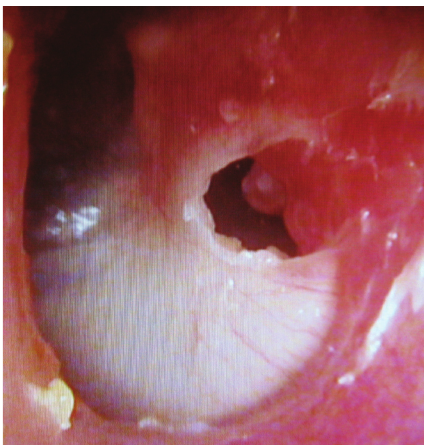
Figure 1: Otoendoscopic view of the left ear with a white lesion localized in the posterosuperior, posteroinferior, and anteroinferior quadrants of the tympanic membrane with marginal perforation.